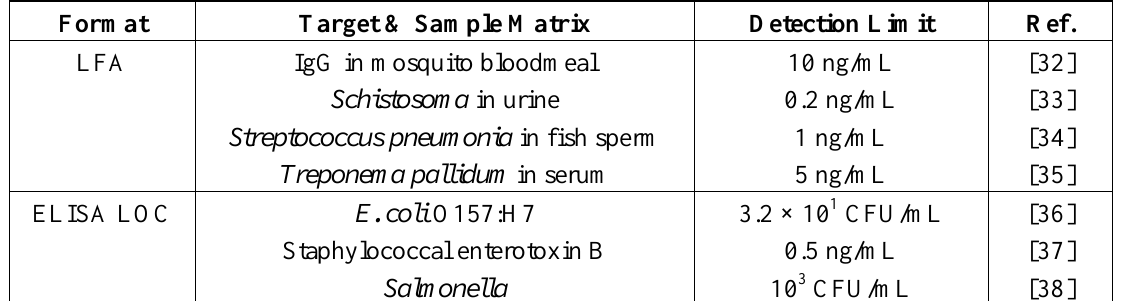
Table 1. Summary of detection limits for various types of immunoassay lab-on-a-chips for foodborne